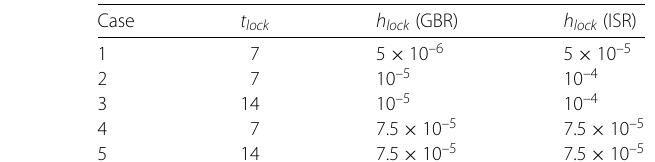
Table 4 Parameters for different cases of Scenario 9